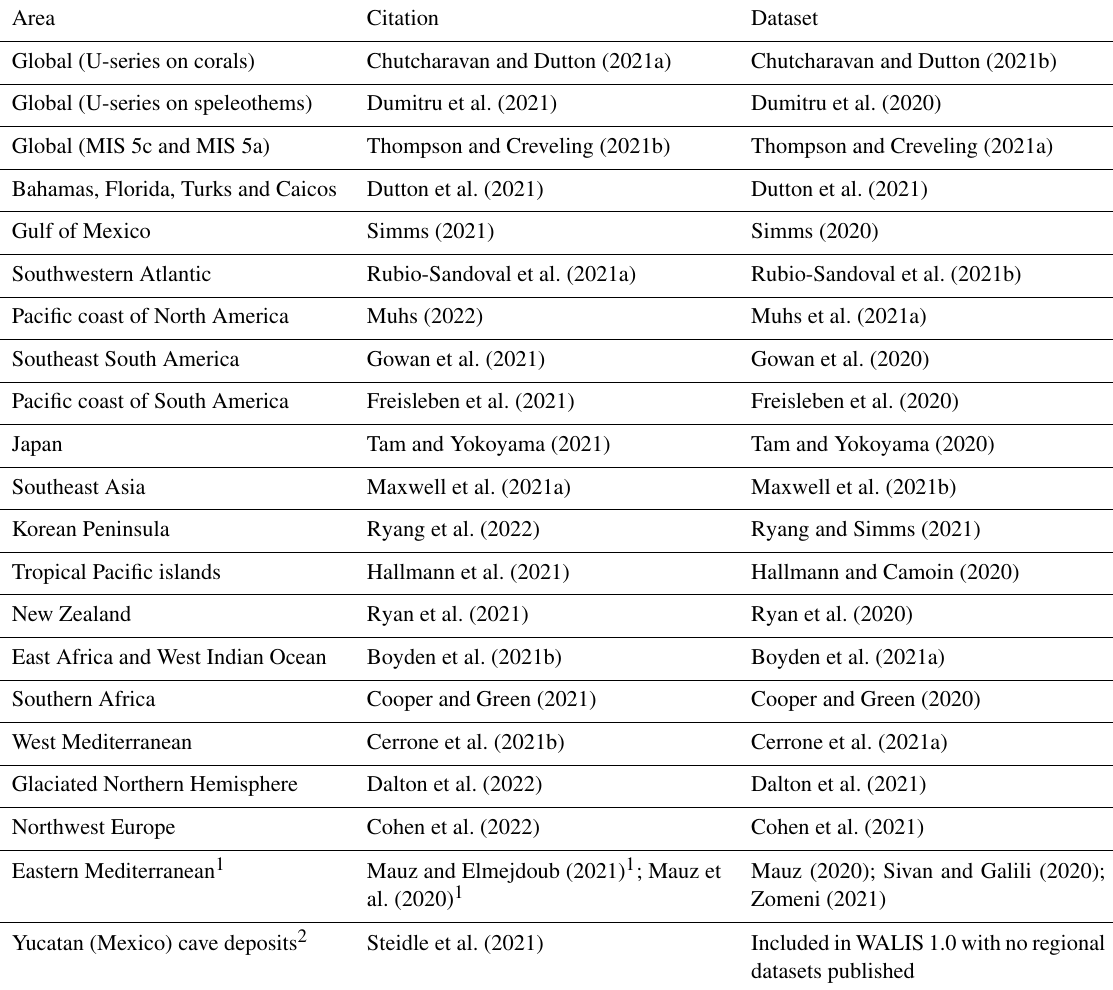
Table 2. List of papers describing data compiled in WALIS format and associated